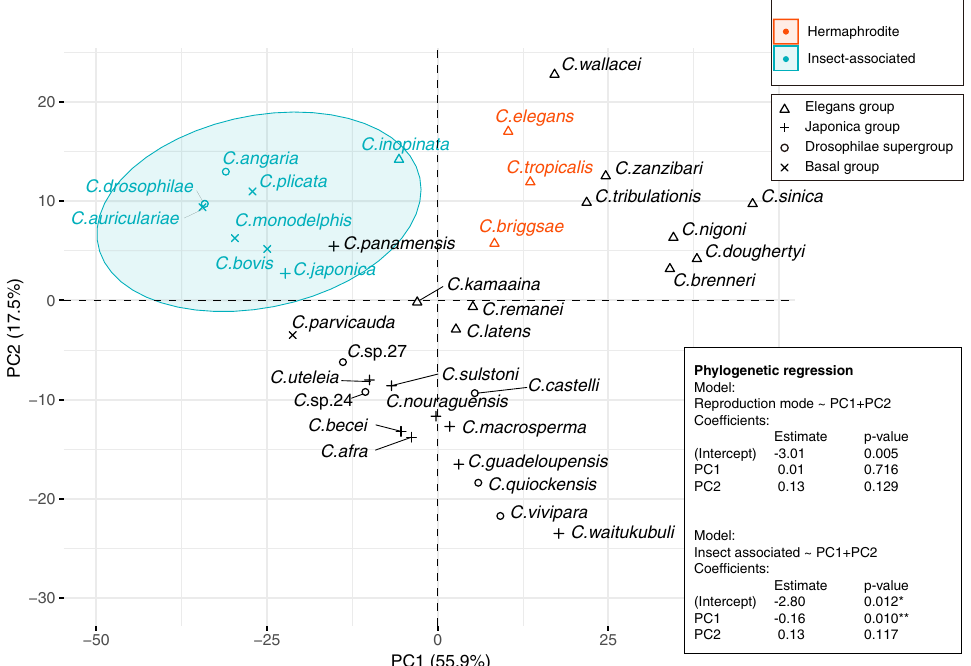
Figure 6. Principle component analysis (PCA) score plot of Carbohydrate active enzyme (CAZy) distribution. The first two axes explain 55.9% and 17.5% of total variance, respectively. Taxonomic groups and ecological traits (hermaphrodism and insect association) are indicated by point shapes and colours, respectively. The ellipse in the plot illustrates the 95% prediction region. The best models of phylogenetic logistic regression for the ecological traits with PCs were shown in